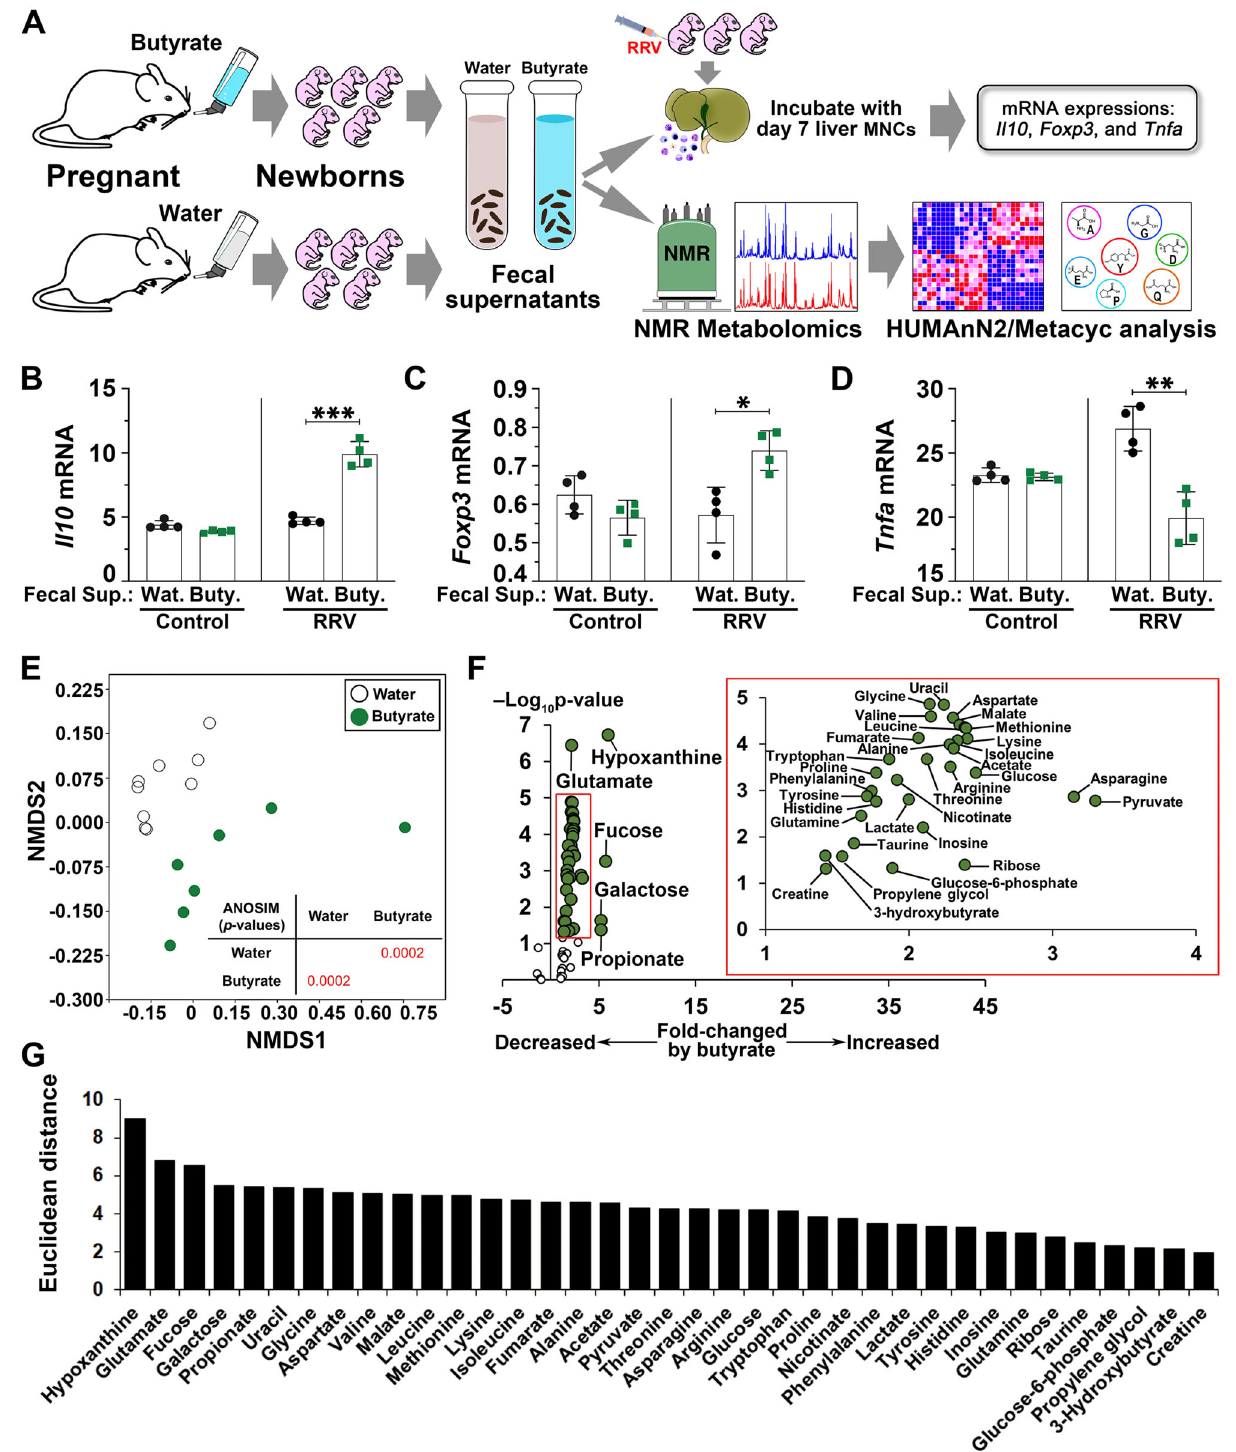
Fig. 4 Murine fecal metabolites suppress activated immune cells and are enriched with hypoxanthine/inosine and glutamate/glutamine. A Schematic illustration of in vitro fecal supernatant – immune cell cultures and stool metabolite analysis. mRNA expression for Il10 ( B ), Foxp3 ( C ), and Tnfa ( D ) as a ratio to Gapdh in RRV-primed hepatic MNCs cultured in the presence of fecal supernatants from neonatal mice of water- or butyrate-fed mothers (mean ± SD, two-tailed unpaired Student ’ s t test, n = 4 per group; * p < 0.05, ** p < 0.01, *** p < 0.001). E NMDS and ANOSIM of metabolites in fecal supernatants of neonatal mice from water- or butyrate-fed mothers at 14 days of age. F Volcano plot illustrating fecal metabolites with p values and fold changes between neonatal mice from water- and butyrate-fed mothers (inset depicts metabolites of lower distance). The replicate values were determined using biologically distinct samples and p values calculated using unpaired Student ’ s t test with two-tailed distribution. G Fecal metabolites ordered by Euclidean distance measured from the volcano plot. Source data for this fi gure are provided as a Source data fi le.